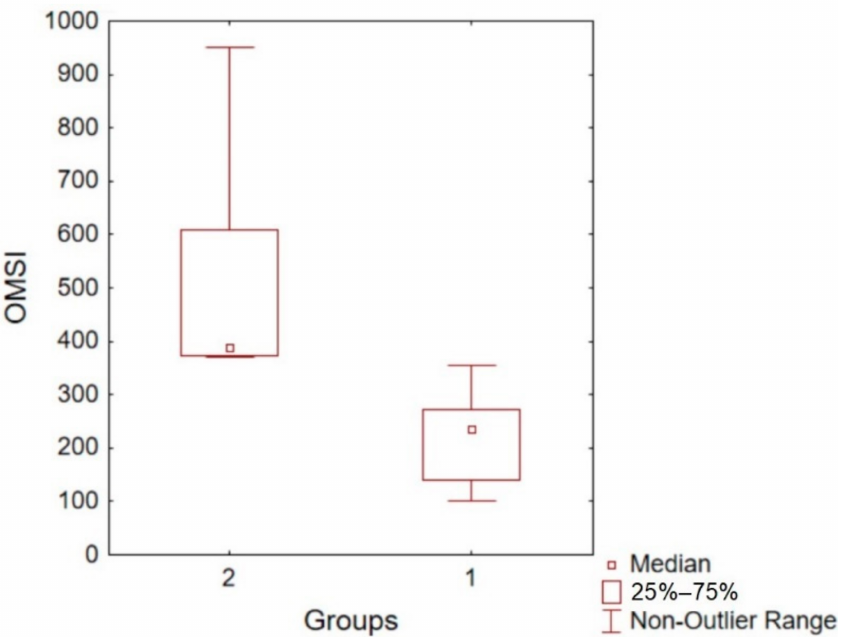
Figure 2. Boxplot for OMSI. Group 1 = less musically sophisticated; Group 2 = more musically